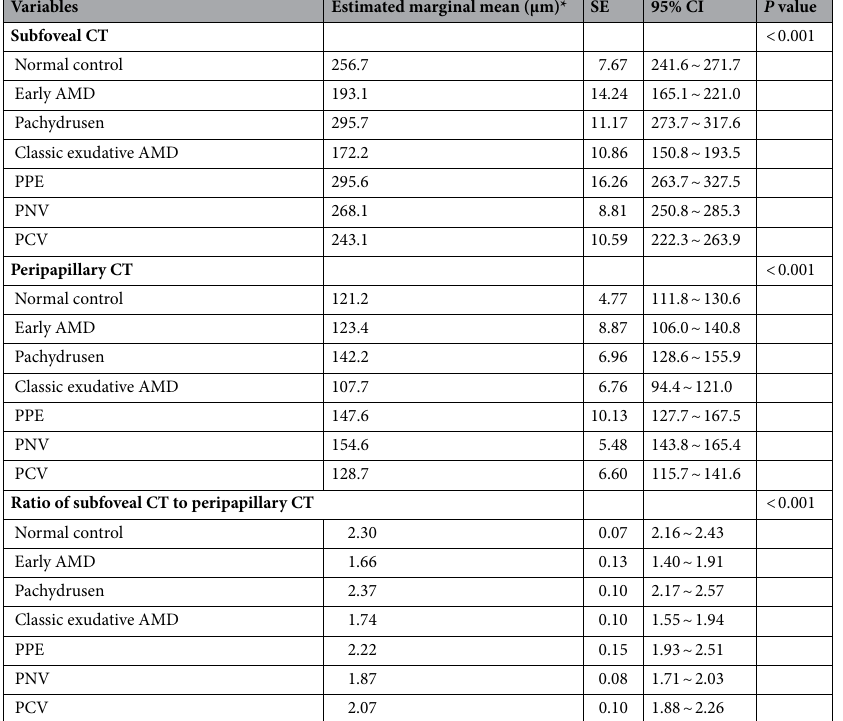
Table 3. Estimated marginal means with 95% confidence intervals. SE, standard error; CI, confidence interval; CT, choroidal thickness; AMD, age-related macular degeneration; Early AMD, early AMD group with soft drusen or reticular pseudodrusen; PPE, pachychoroid pigment epitheliopathy, PNV, pachychoroid neovasculopathy; PCV, polypoidal choroidal vasculopathy. *Evaluated at covariates appeared in the model: Age =